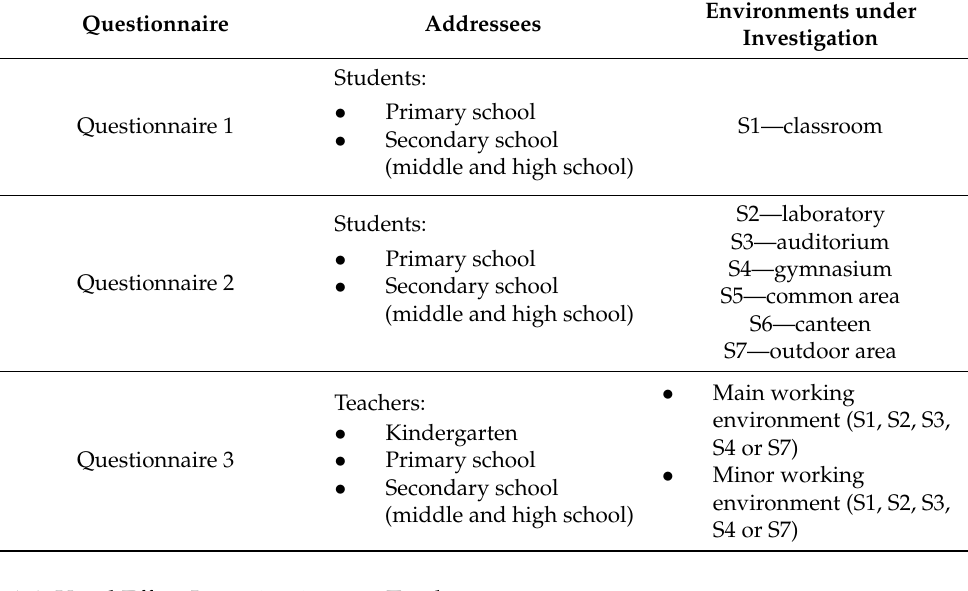
Table 1. The three questionnaires: addresses and environments under